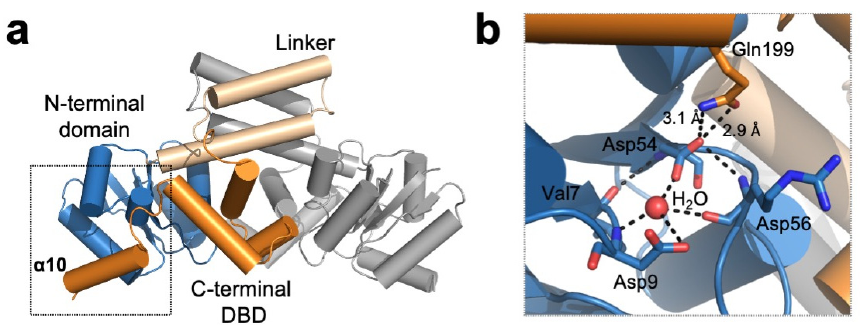
Figure 7. M tuberculosis DosR is in an autoinhibited state. ( a ) Overall structure of M. tuberculosis DosR (chain A: blue, ivory, orange; chain B: gray. PDB ID: 3C3W). The N-terminal domain (blue) interacts with the C-terminal DNA-binding domain (orange), suggesting that DosR adopts an autoinhibited state. ( b ) The DosS/T kinase substrate Asp54 plays a critical role in stabilizing autoinhibitory interactions by forming a hydrogen bond with Gln199 in the α 10 helix. Residues involved in hydrogen bonding with Asp54 are shown as sticks.